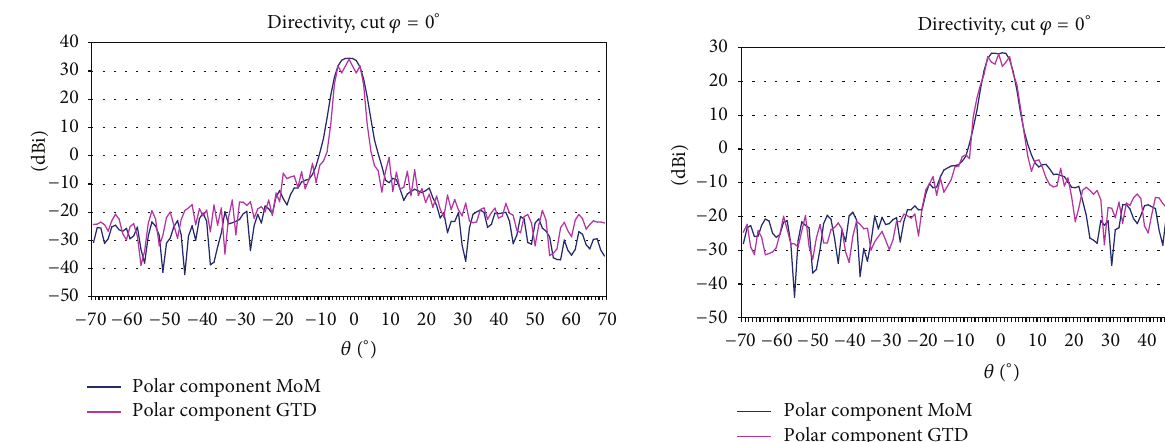
Figure 24: Polar component obtained with MoM and GTD, cut in phi = 0.